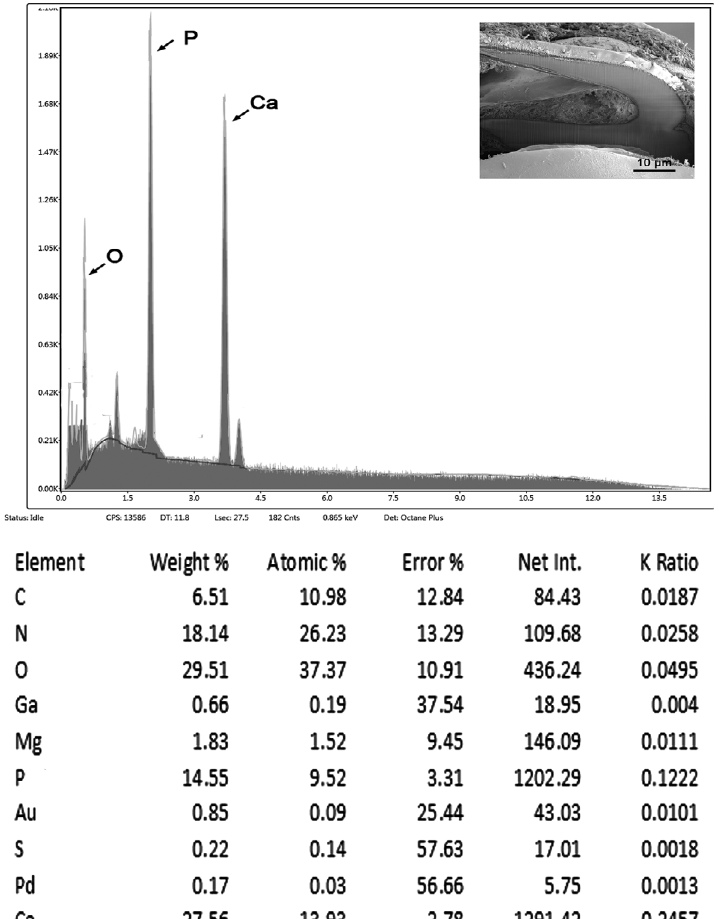
Figure 21. Energy Dispersive X-Ray spectrum of the base center of a large hook of a Neoechinorhynchus johnii specimen showing high levels of calcium and phosphorus (see Table 4). Insert: SEM of a lateral longitudinal gallium cut hook. The X-ray data are the elemental analysis of the hook